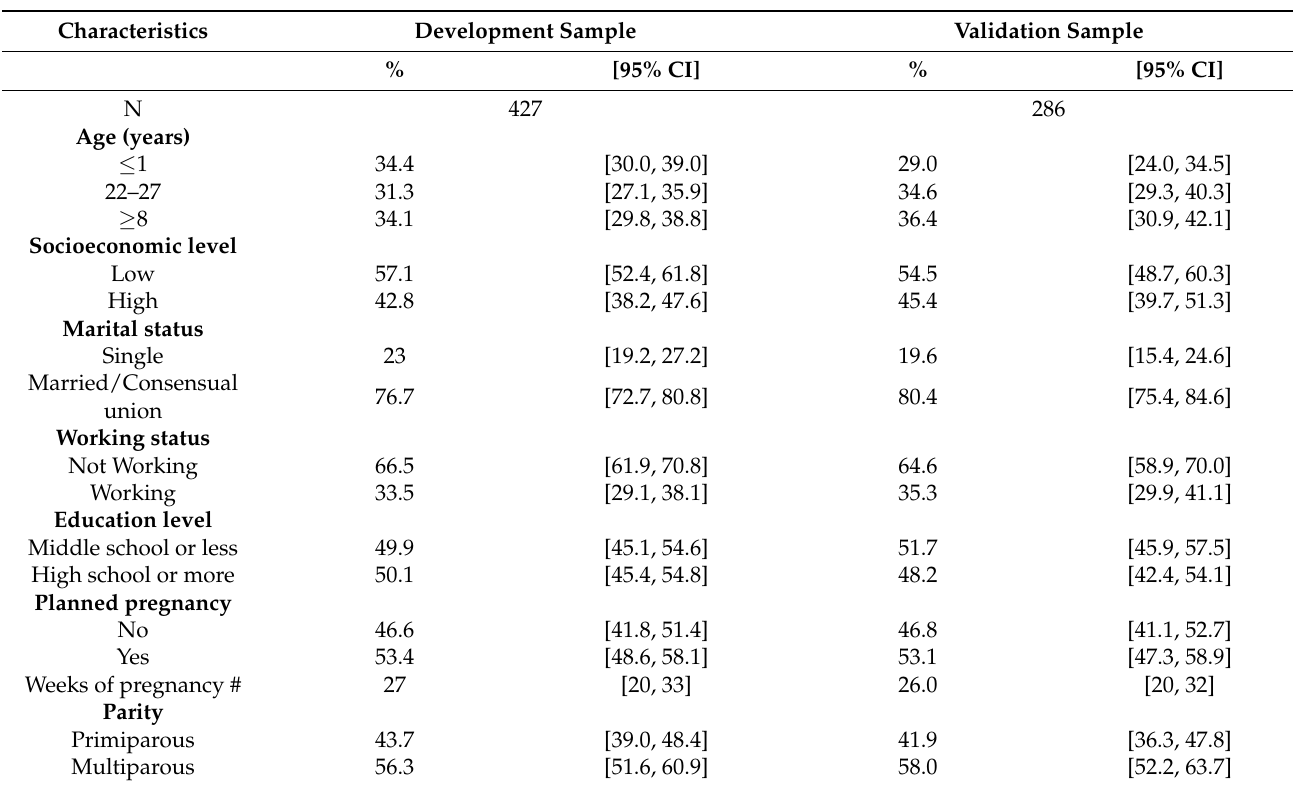
Table 1. Distribution of sociodemographic and pregnancy characteristics of development and valida- tion samples a